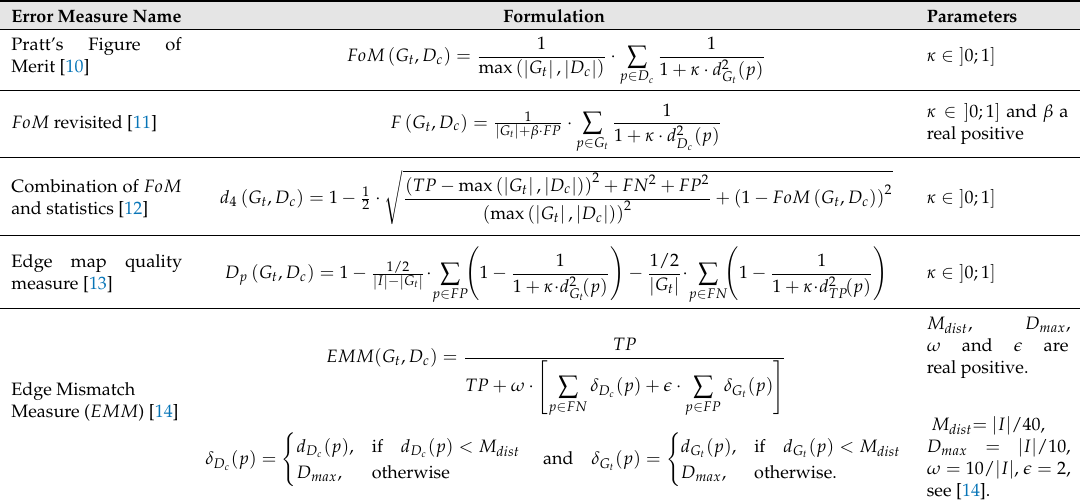
Table 1. List of normalized dissimilarity measures involving distances, generally: κ = 0.1 or